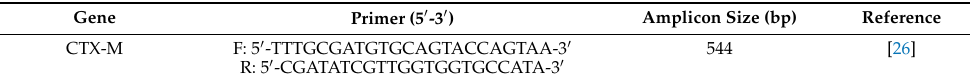
Table 1. Nucleotide sequence of the primer used in the detection of bla CTX-M gene.